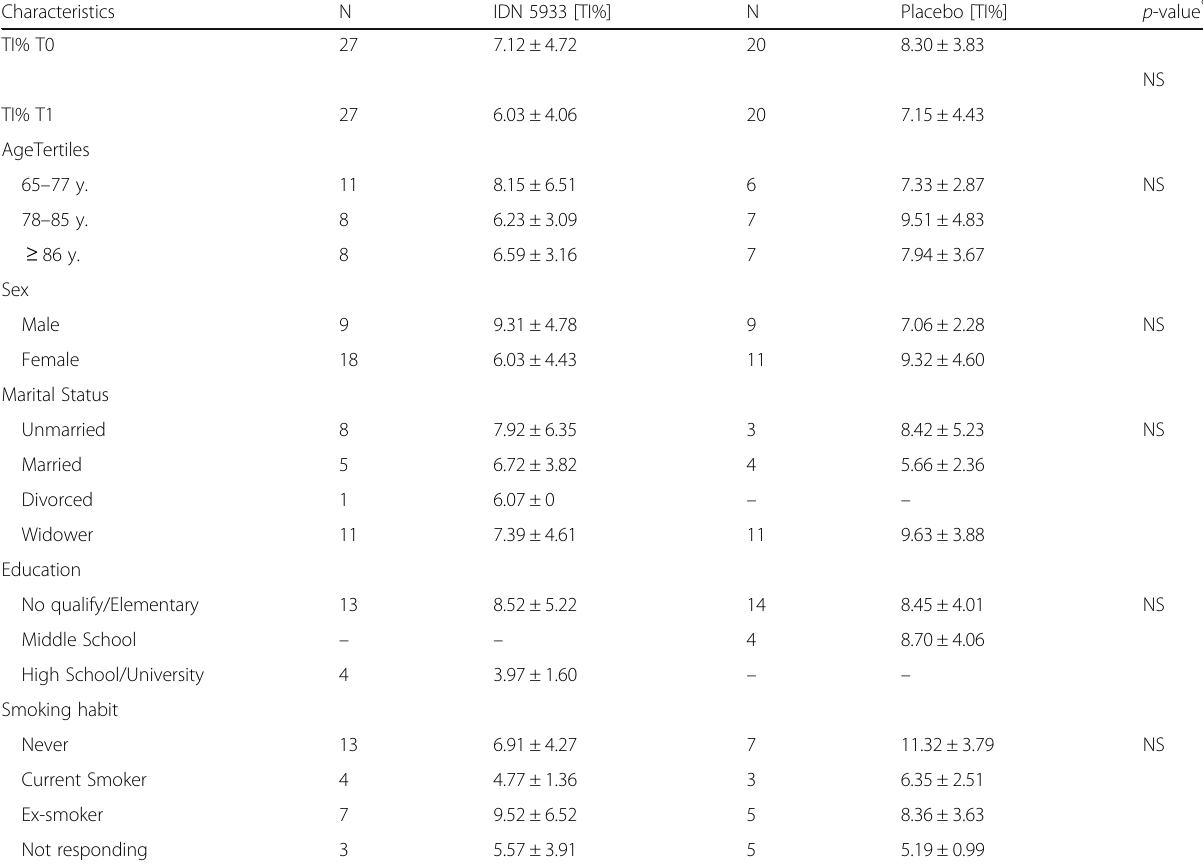
Table 4 DNA damage [Mean ± SD]according to main individual characteristics of participants to the GIBIEX study [values at T0] Characteristics